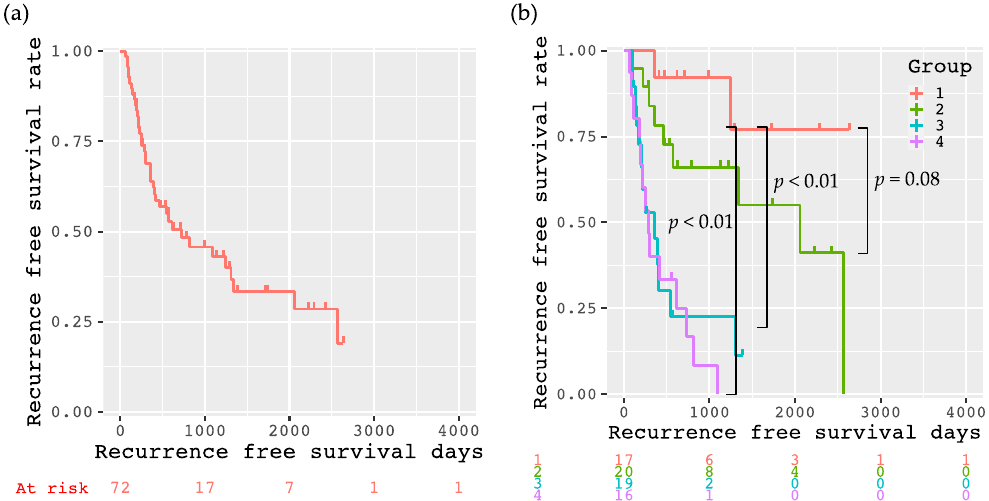
Figure 3. Kaplan–Meier curves for recurrence-free survival after curative treatment in all participants ( a ), and divided into four groups according to the decision-tree analysis ( b ). Group 1 meets the following conditions: VATI < 71 cm 2 /m 2 and FIRI < 5.5 µU/mL; Group 2: VATI < 71 cm 2 /m 2 , FIRI ≥ 5.5 µU/mL, and AFP < 11 ng/mL; Group 3: VATI < 71 cm 2 /m 2 , FIRI ≥ 5.5 µU/mL, and AFP ≥ 11 ng/mL; and Group 4: VATI ≥ 71 cm 2 /m 2 .